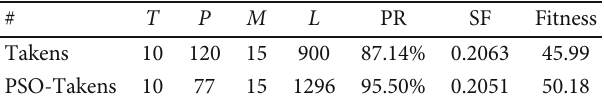
Table 4: Parameter changes of knee joint prediction algorithm under standard gait